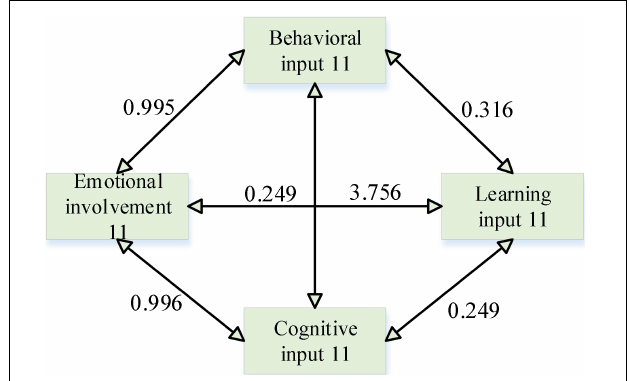
FIGURE 3 | Path diagram of non-English majors.